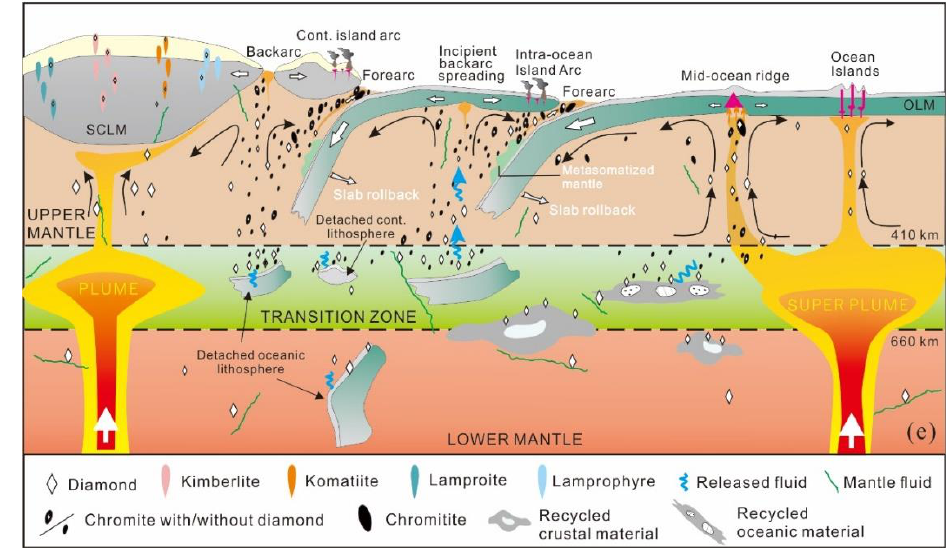
Figure 7. Different genetic models of diamond, peridotite and podiform chromitite in ophiolites. ( a , b ) — after [38]; ( c ) — after [91]; ( d ) — after [92]; ( e ) — modified after [37,133]. BAB — backarc basin; lites. ( a , b )—after [38]; ( c )—after [91]; ( d )—after [92]; ( e )—modified after [37,133]. BAB—backarc Cont. — continental; MOR — mid-ocean ridge; OLM — oceanic lithospheric mantle; OP — oceanic basin; Cont.—continental; MOR—mid-ocean ridge; OLM—oceanic lithospheric mantle; OP—oceanic plateau; SCLM — subcontinental lithospheric mantle. plateau; SCLM—subcontinental lithospheric